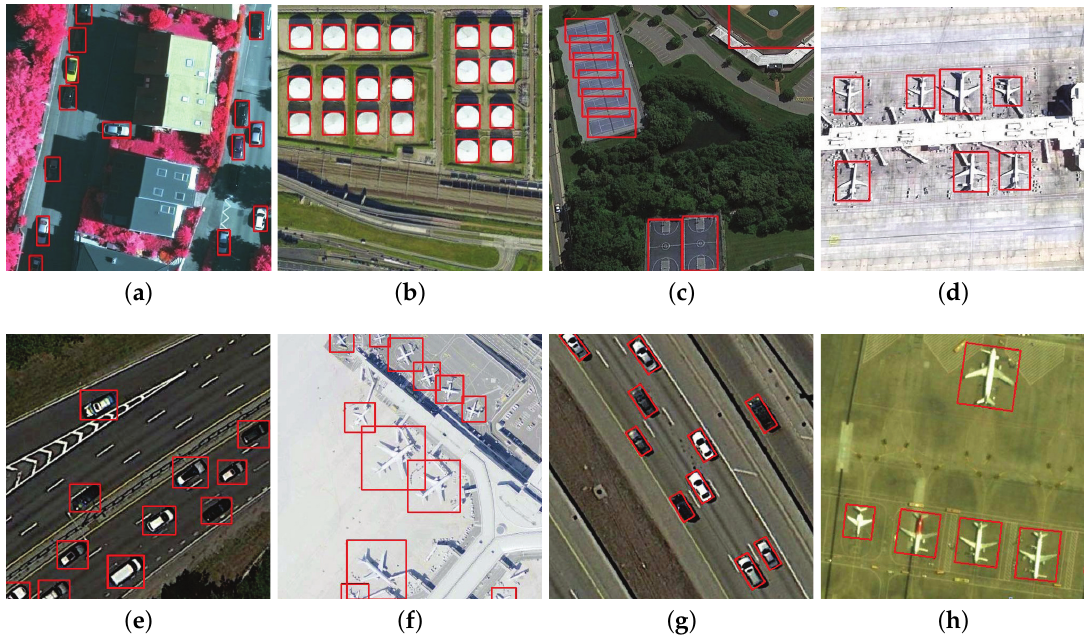
Figure 5. The visual results on NWPU VHR-10 and UCAS AOD datasets. ( a – d ) HBB task for NWPU VHR-10; ( e – f ) HBB task for UCAS AOD; ( g – h ) OBB task for UCAS AOD.